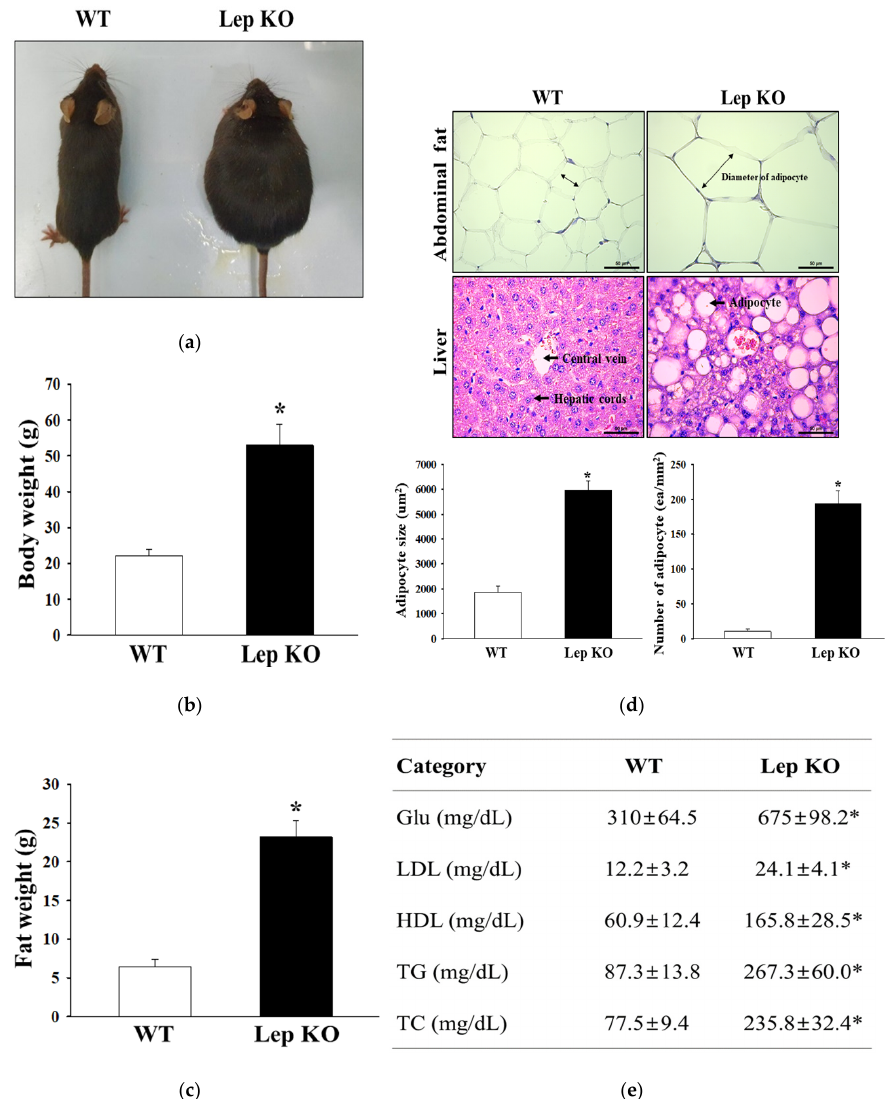
Figure 1. Obesity phenotypes of Lep KO mice. ( a ) Morphology of WT and Lep KO mice was observed at 24 weeks of age; ( b ) Body weights of the mice of the subset group were measured, as described in Materials and Methods. Five to six mice per group were selected from each group, and their weights were assayed in duplicate for each sample; ( c ) After collecting the retroperitoneal fat, their weights were measured using an electric balance. Five to six mice per group were used to collect the fat tissues; the weight of fat tissue was measured in duplicate for each tissue; ( d ) After hematoxylin and eosin (H&E) staining of the fat and liver tissue, their histopathological features were observed at 100× magnification using an optical microscope. The area of each adipocyte in fat and lipid droplets in the liver was measured using the Image J program. Five to six mice per group were used in histological analysis, and each parameter was measured in duplicate in two different slides; ( e ) Serum levels of Glu, LDL-C, HDL-C, TG, and TC were determined in all mice of the subset groups. Five to six mice per group were used in the preparation of serum. Biochemical analysis was assayed in duplicate for each sample. Data are reported as the mean ± SD. * indicates p < 0.05 compared to WT mice. Abbreviations: M, Marker; WT, Wild type; KO, Knockout type; TC, total cholesterol; TG, triglyceride; LDL-C, low-density lipoprotein–cholesterol; HDL-C, high-density lipoprotein–cholesterol; Glu,